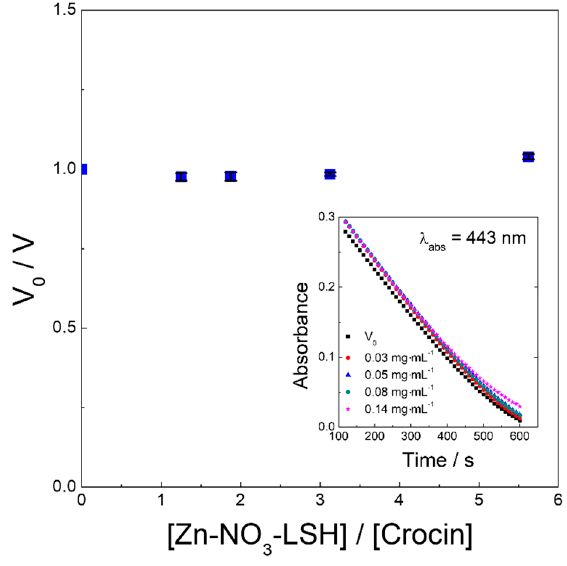
Figure A7. Representation between velocities and concentrations of the Zn-NO 3 -LSH matrix in the crocin bleaching assay. V 0 , velocity in the absence of the host matrix; V, velocity in the presence of the Zn-NO 3 -LSH matrix.